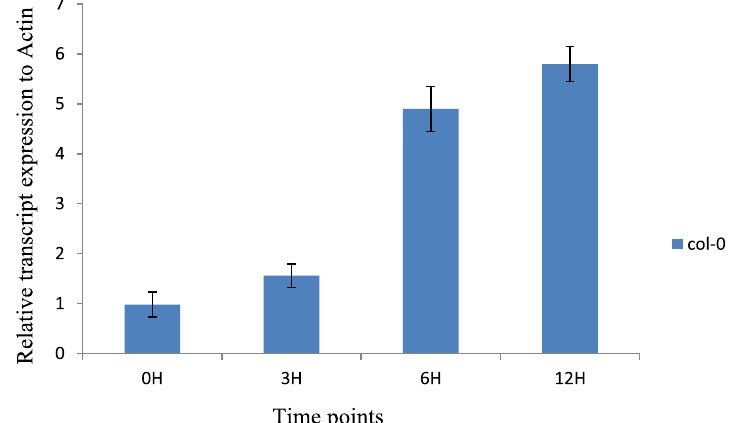
Fig. 1 Relative AtPCR2 m-RNA expression level while Pseudomonas fluorescens and Arabidopsis thaliana interaction . Bars indicate standard deviation ( n 3). Statistically significant differences (Student’s t test) between transgenic lines and Col-0 were indicated ( p < 0.05) =